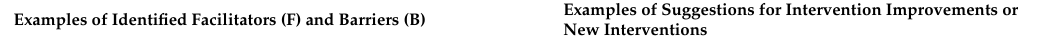
Table 1. Summary findings from stakeholder focus group and